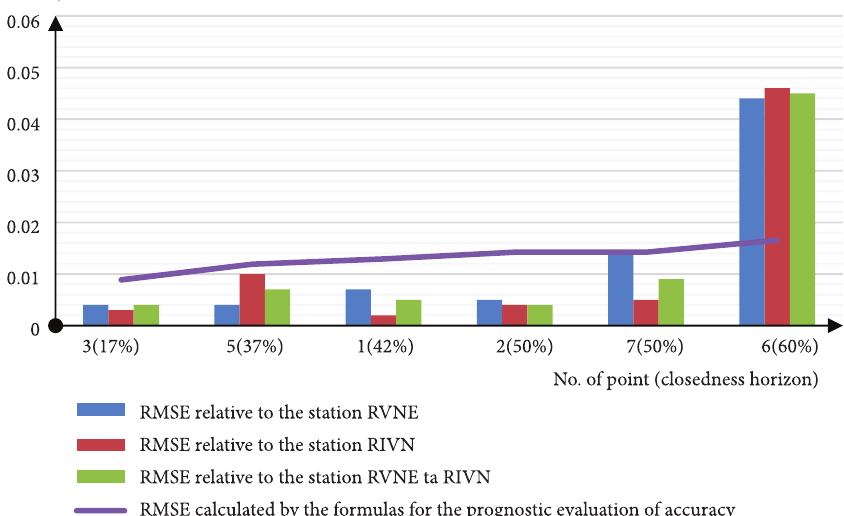
Figure 5. Comparison of RMSE of the height location by the session duration for 1 hour with executing the preliminary planning and prognostic points of accuracy evaluation calculated by Equation